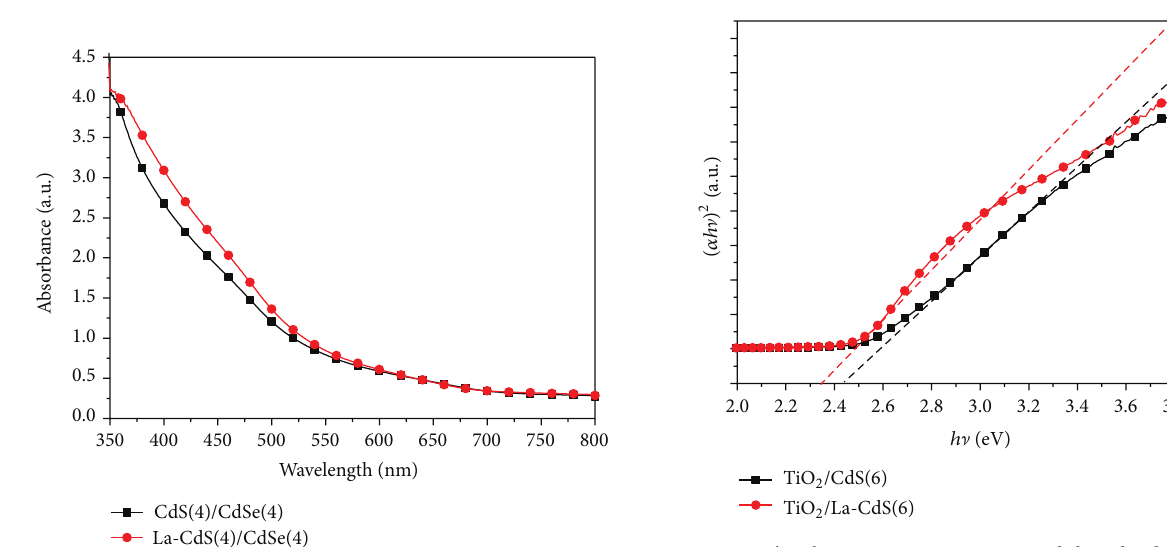
Figure 5: The XRD patterns of La-doped-CdS/CdSe films.